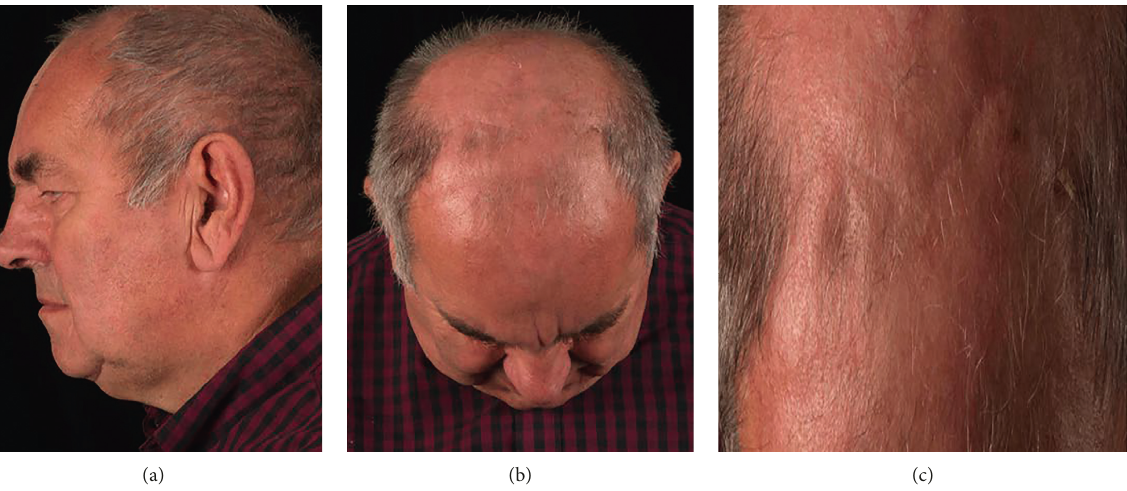
Figure 5: Postoperative images (12months).